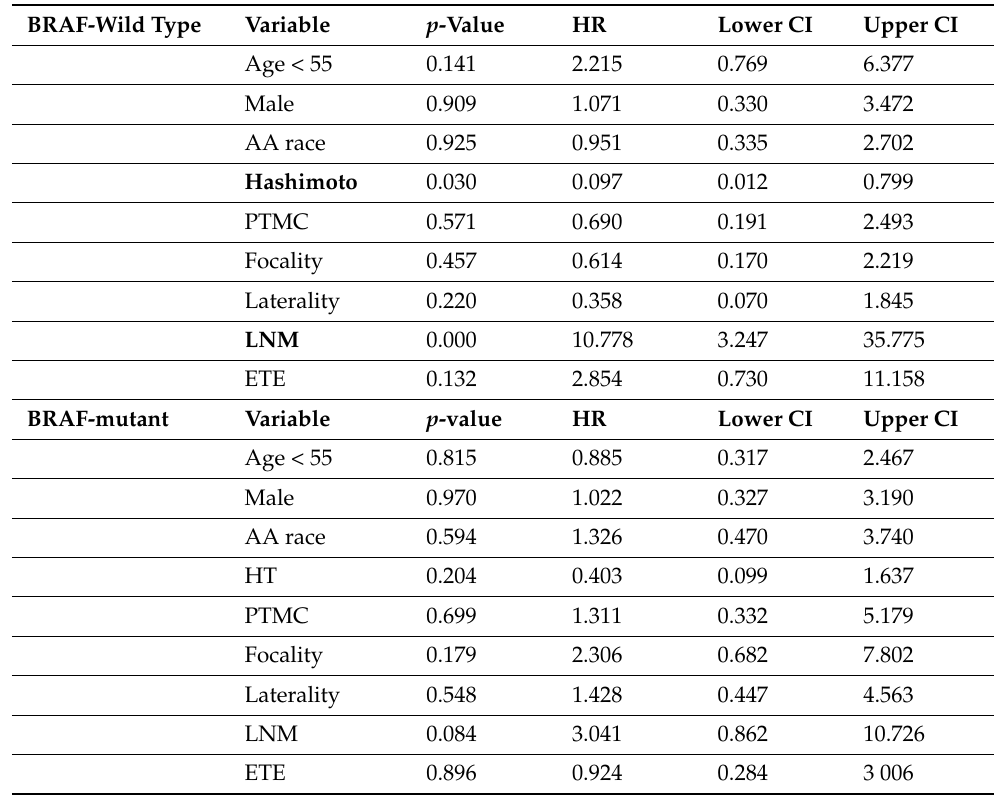
Table 3. Multivariate logistic regression analysis determining independent predictors of recurrence sub-grouped by BRAF mutation status.